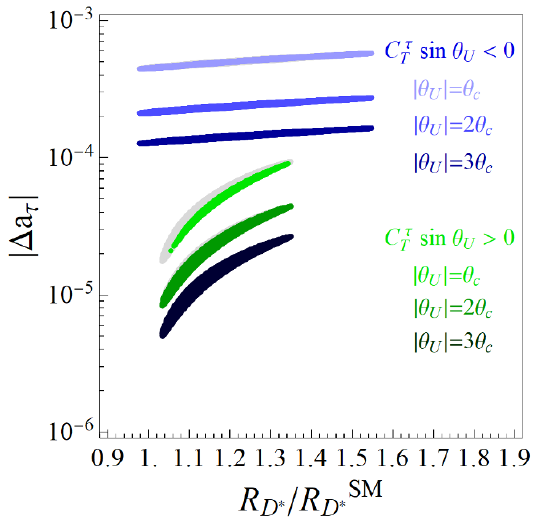
Figure 7 . R D (cid:3) =R SM with (cid:12)xed values